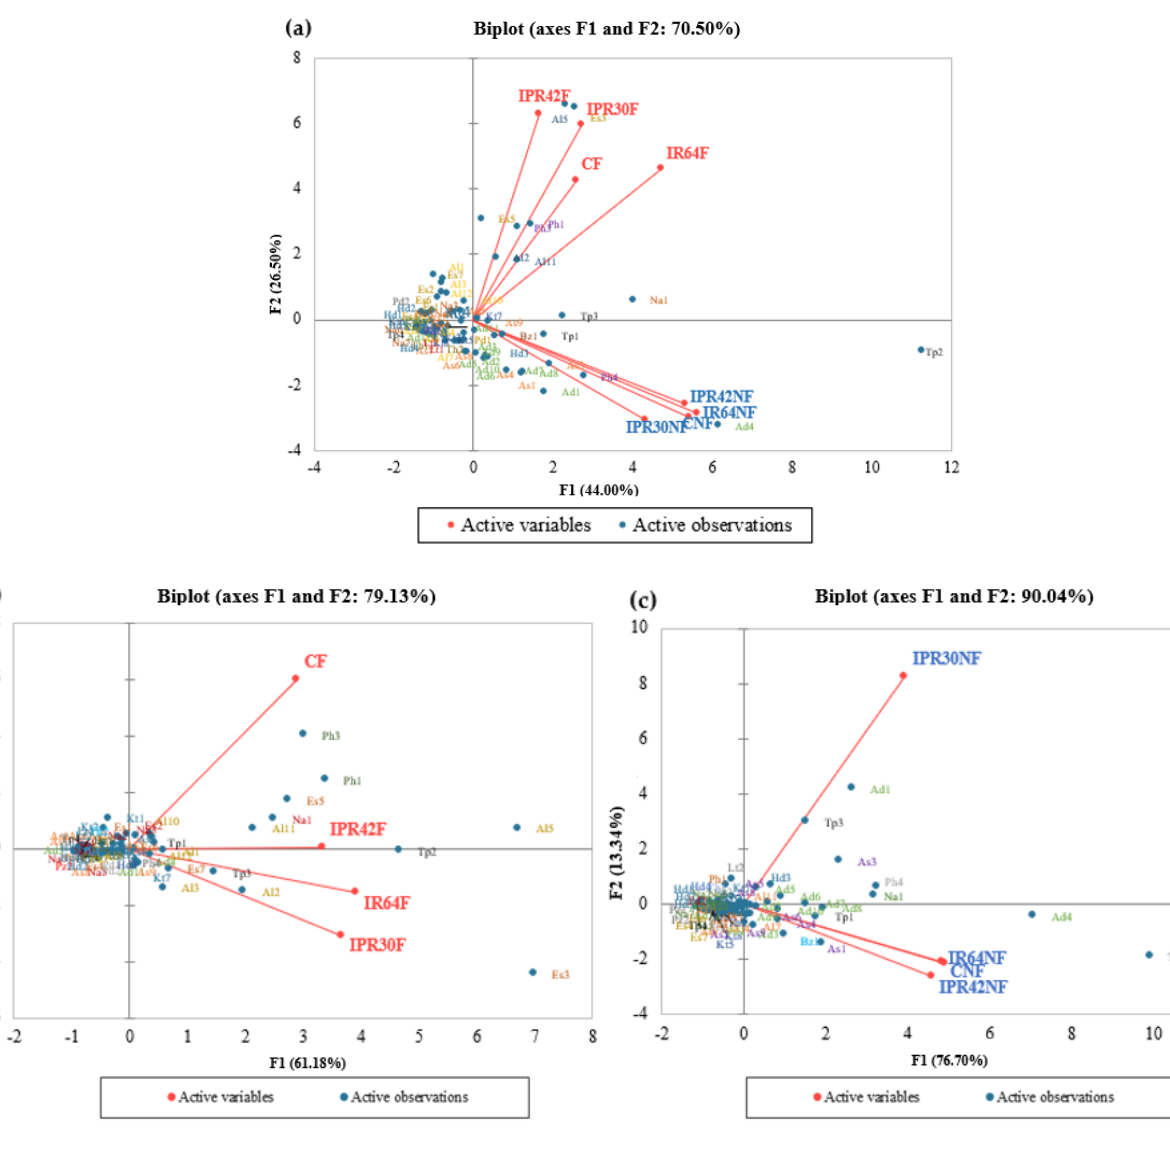
Figure 2. Volatile compound: ( a ) FRB and NFRB; ( b ) Ciherang fermented; (CF), Inpari42 fermented (IPR42F), Inpari30 fermented (IPR30F), IR64 fermented (IR64F) rice bran; ( c ) Ciherang nonfermented (CNF), Inpari42 nonfermented (IPR42NF), Inpari30 nonfermented (IPR30NF), and IR64 nonfermented (IR64NF) rice